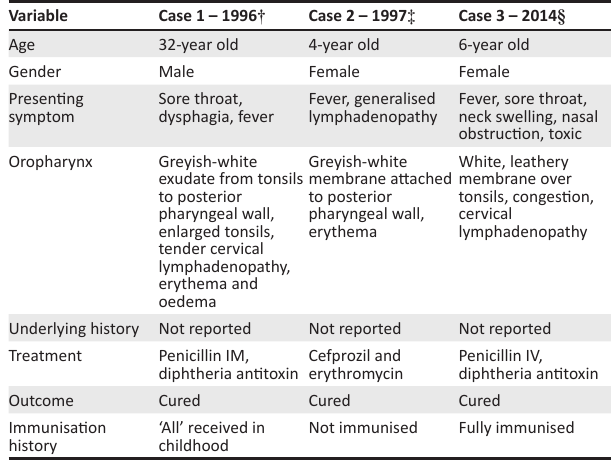
TABLE 2: A summary of important clinical features in reported cases of Corynebacterium pseudodiphtheriticum exudative pharyngitis to date (June